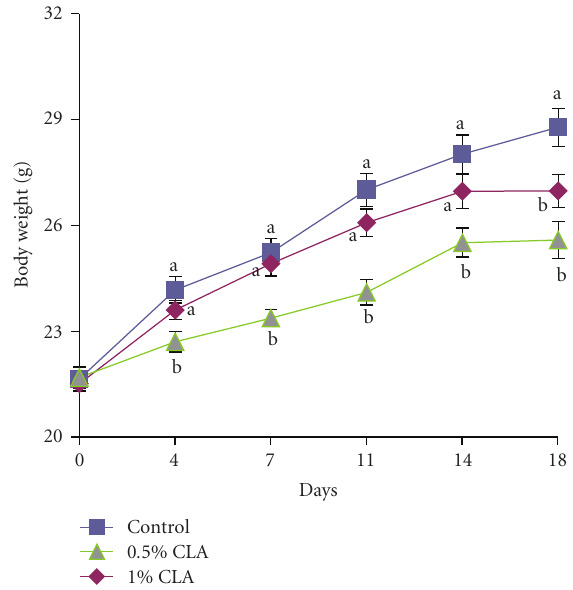
Figure 1: Changes in body weight in mice fed diets containing 0 (control), 0.5%, or 1% CLA for 2 weeks. Values are means ± SEM; N = 4 to 6 in each group. Means at a time with a di ff erent letter are significantly di ff erent, P < . 05.